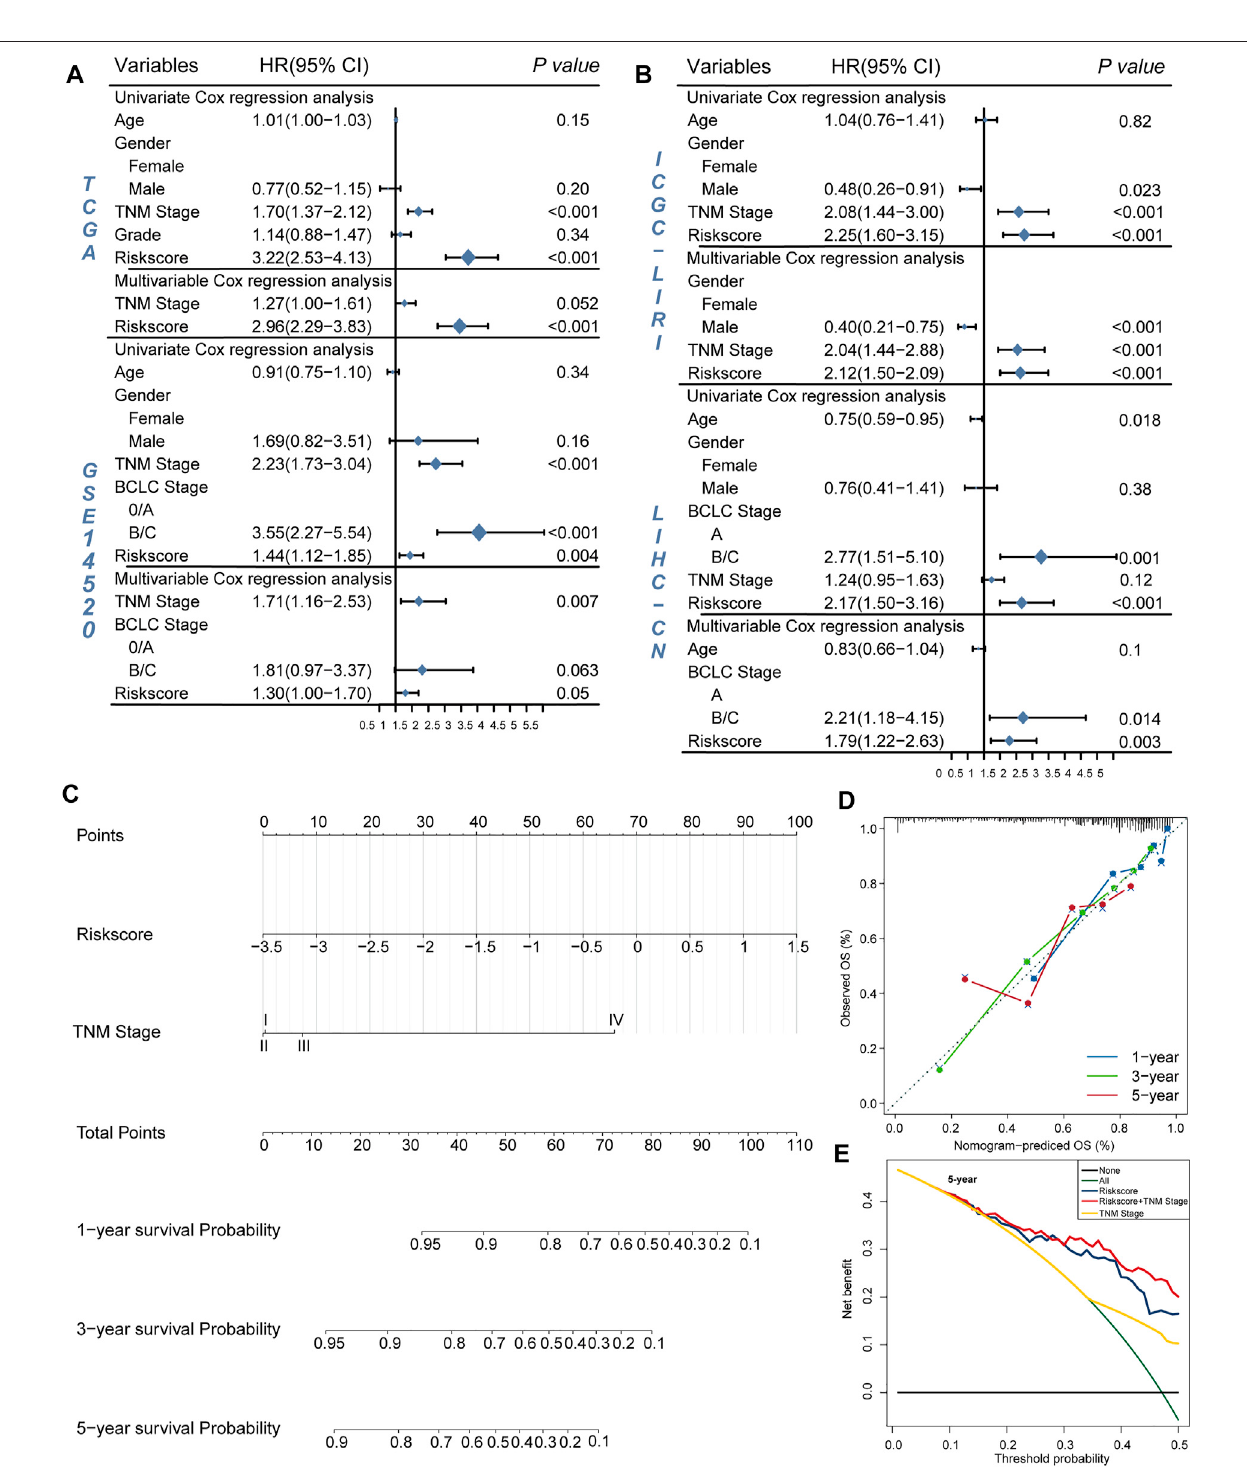
FIGURE 3 | Validation of the independency of the riskscore for prediction of HCC prognosis. (A,B) Univariate and multivariate cox regression survival analysis validated riskscore was an independent prognosis factor for HCC patients in TCGA datasets (A) , GSE14520 datasets (A) , ICGC datasets (B) , LIHC-CN datasets (B) . The p- value, hazard ratio (HR), and 95% con fi dence interval (CI) were indicated in the forest plots. The blue circle represents the value of HR each parameter scored. (C,E) Construct nomogram for survival prediction. (C) which integrated with two independent prognosis factors for predicting the probability of patient mortality at 1-,3-,or5-yearOS. (D) Thecalibration plotsforpredicting patient1-,3-,or5-yearOS. (E) DCAcurves fortwoindependentprognosticfactorsoracombinationofthem in OS prediction.